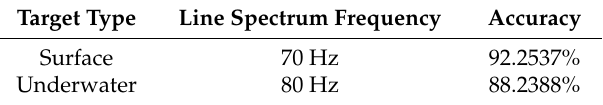
Table 6. Target category-resolution accuracy. Figure 7. The time-frequency distribution of surface and underwater targets. ( a ) Surface target; ( b ) Underwater target.